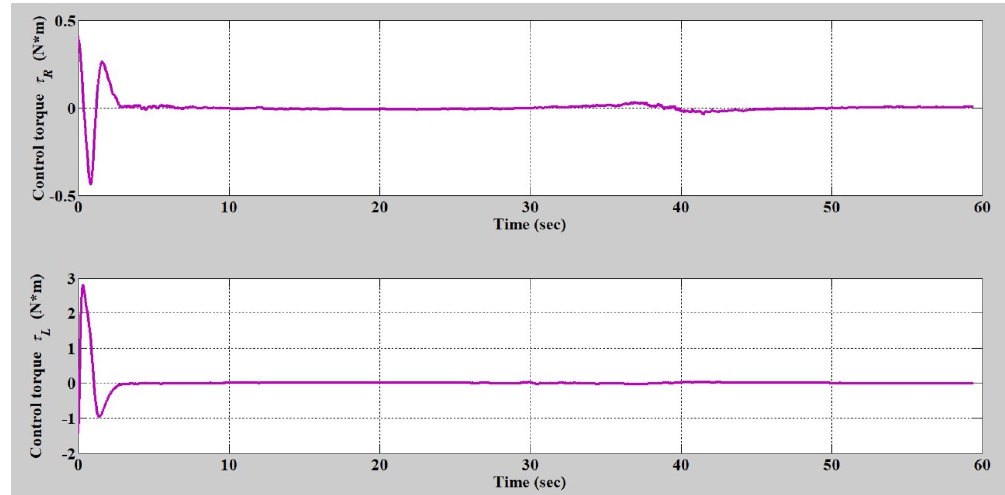
Figure 19. Results of S-type trajectory tracking torques concerning initial point ( x c = 0 m, y c = − 1.9 m).